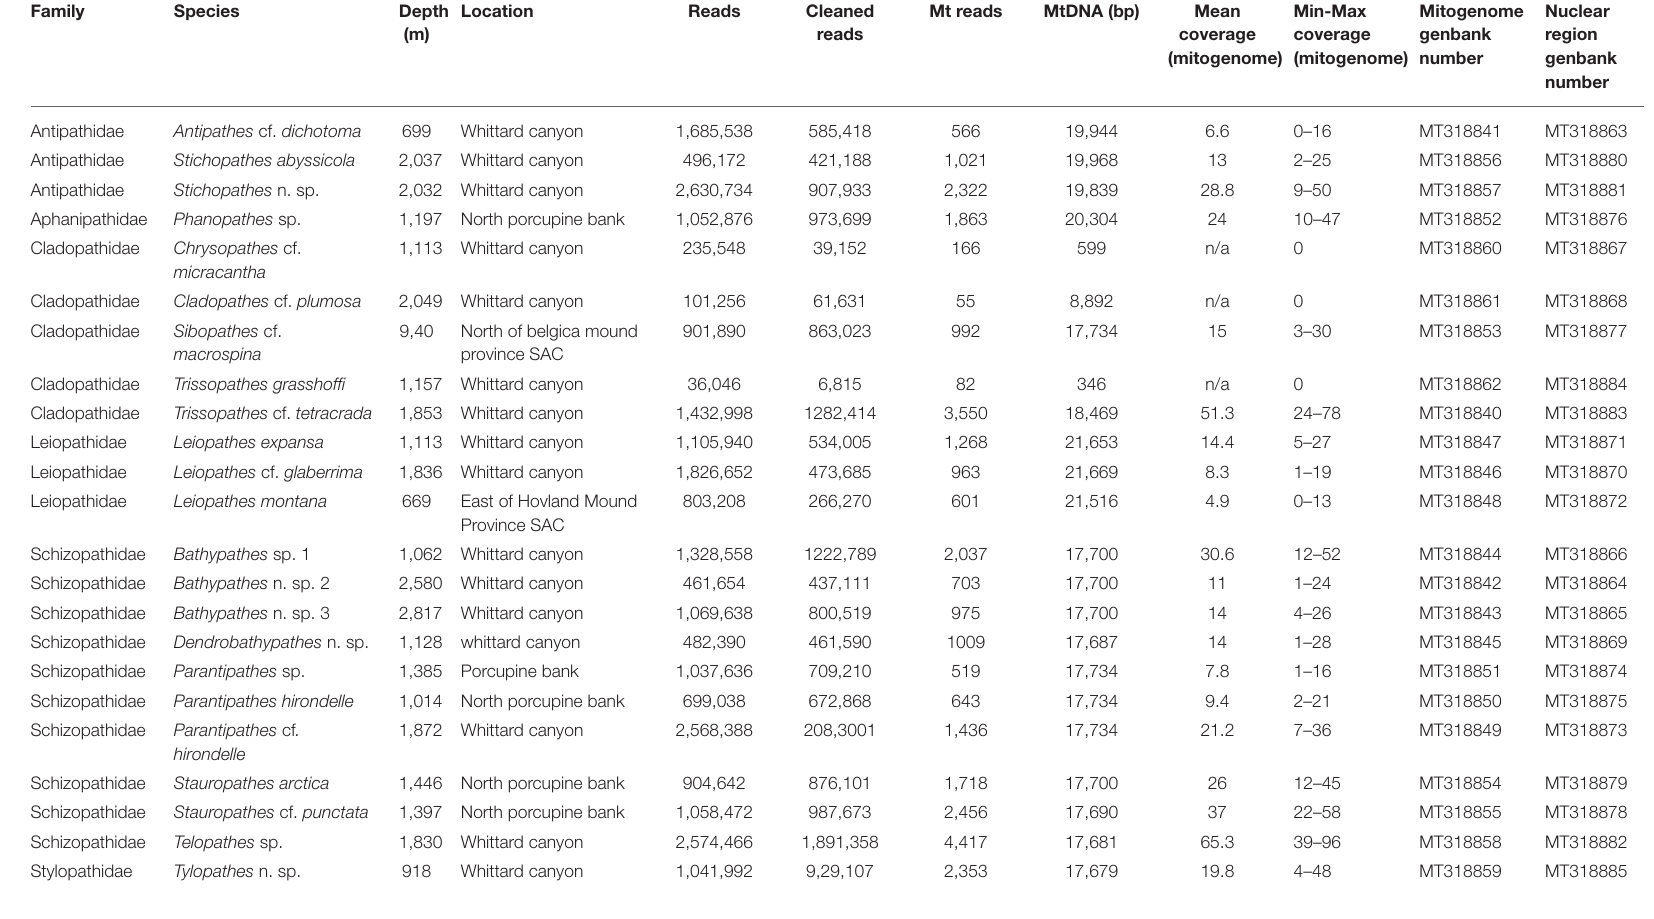
TABLE 1 | Antipatharian samples, GenBank accession numbers, collection information and sequencing data used in this study.